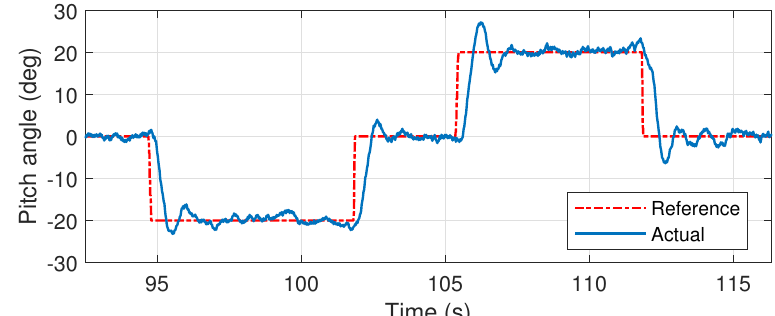
Figure 16. Pitch angular response.